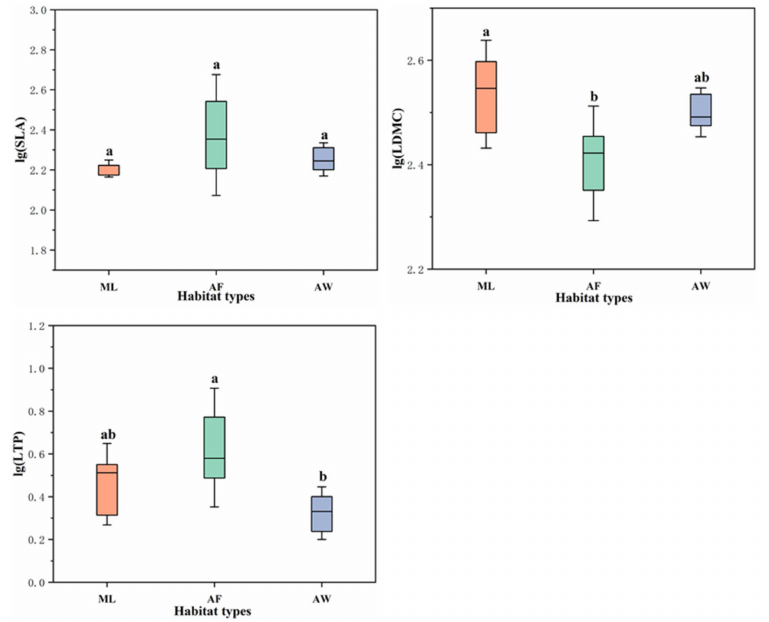
Figure 4. Variance analysis of three LES traits in the plant communities of different habitats (mean ± SD); different letters mean significant differences ( p <